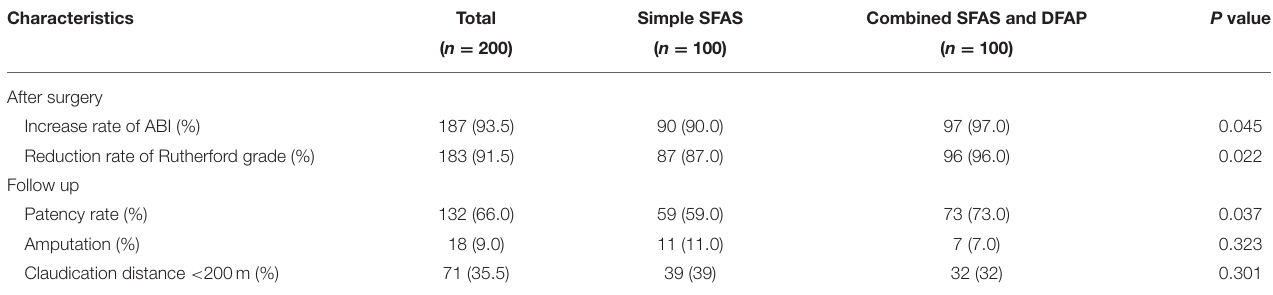
TABLE 2 | Comparison of vascular prognosis after surgery between the two groups. Characteristics